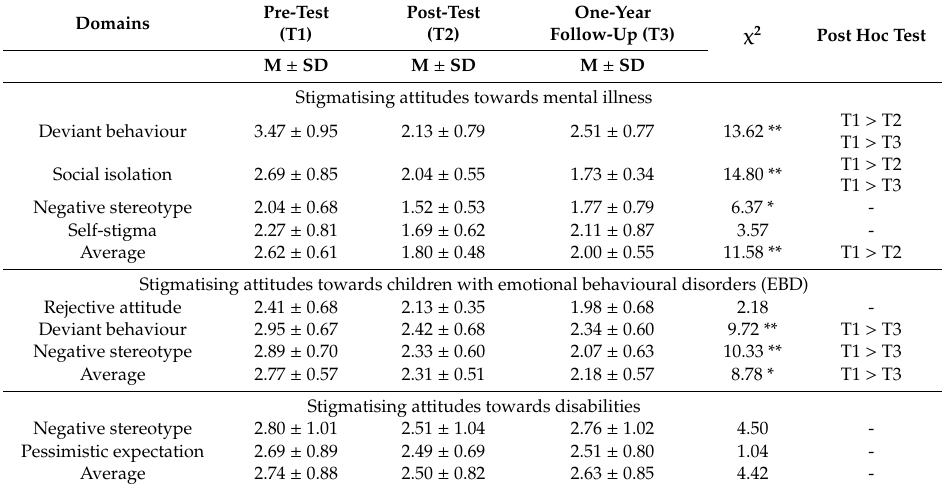
Table 5. The results of Mann–Whitney U tests on the pre-test / follow-up change scores between students who completed the course ( n = 15) and those who dropped the course ( n = 10).